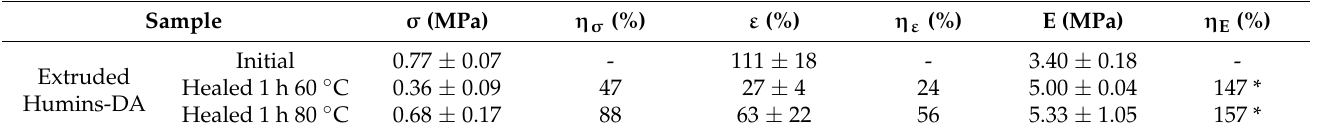
Figure 6. SEM images of the extruded Humins-DA cross-section. Table 4. DMA parameters obtained for extruded Humins-DA, together with the respective healing efficiencies at both 60 and 80 ◦ C for 1